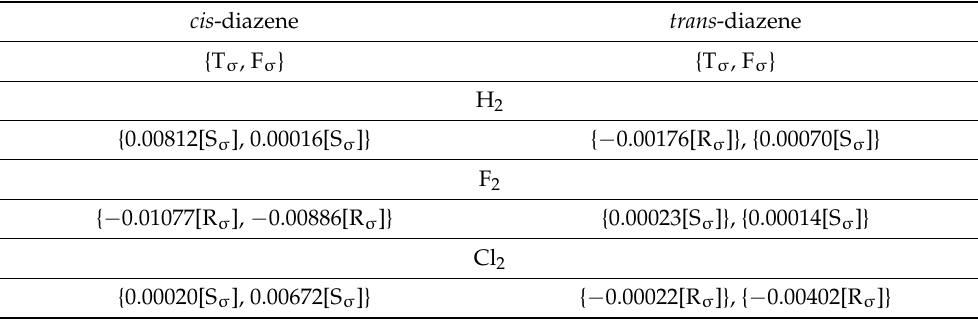
Table 2. The U σ -space bond cross-section sets {T σ ,F σ } of the C1-C2 BCP for the doubly substituted diazene